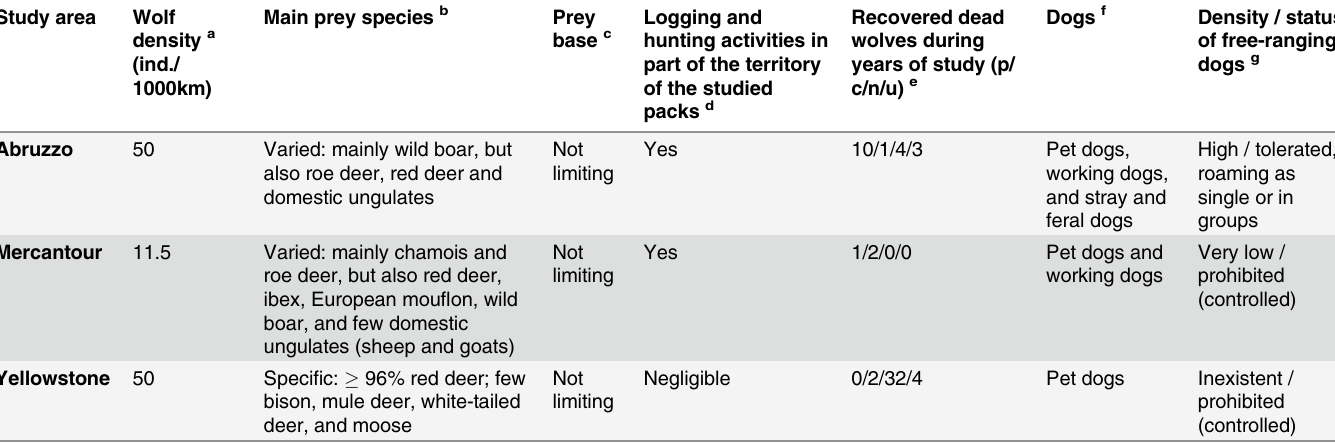
Table 2. Ecological characteristics of the investigated wolf populations at the time of sample